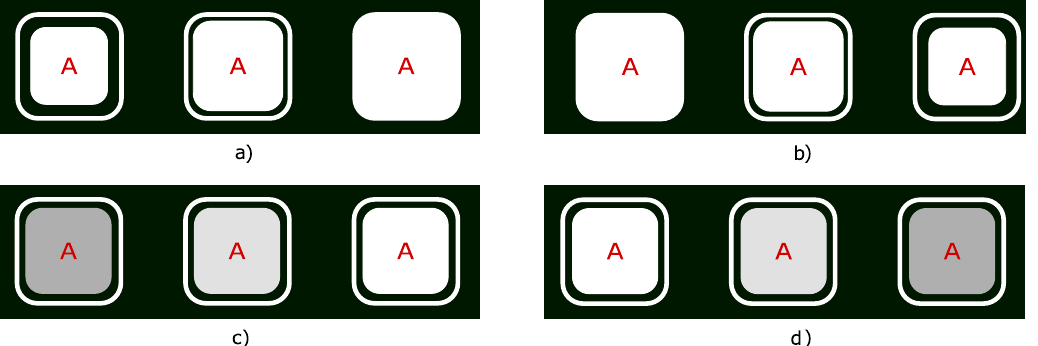
Figure 3. The four used feedback methods: ( a ) “ size increasing ”; ( b ) “ size decreasing ”; ( c ) “ contrast increasing ”; ( d ) “ contrast decreasing ”. The left column depicts how stimuli with a low assigned probability were displayed, the middle column shows stimuli with a probability about half of the threshold, and the right columns shows stimuli with probability at or above the